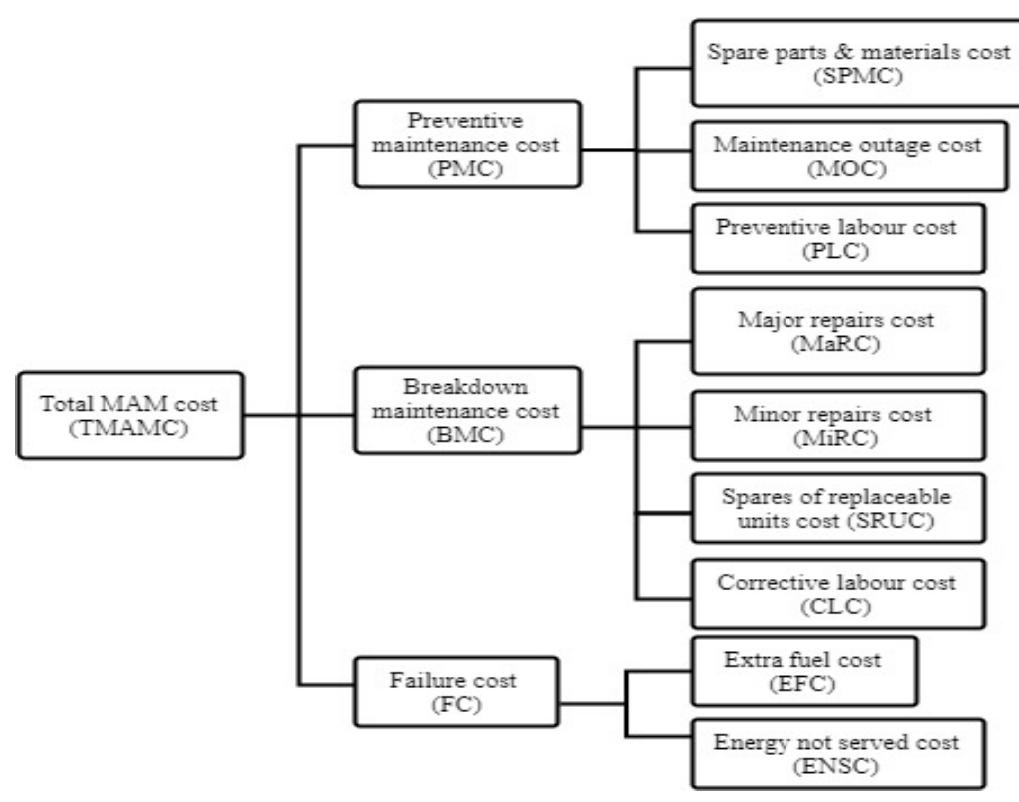
Figure 10. Typical relationship between critical cost elements of PTs.